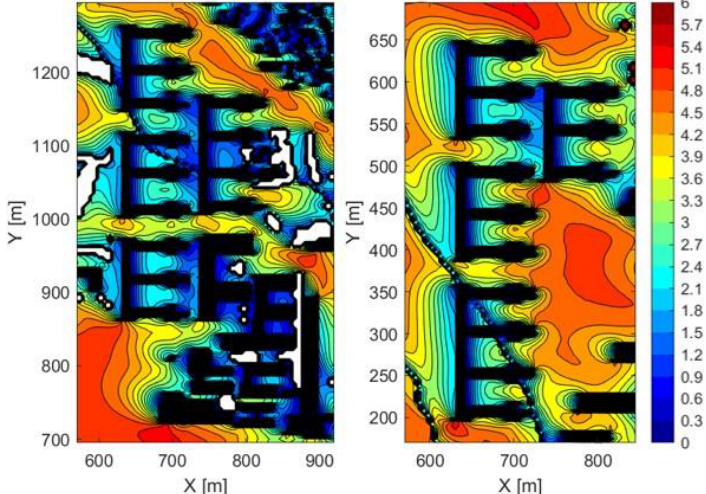
Figure 12. Wind velocity [m/s] at pedestrian level: on the left, in the current situation; on the right, in the planned situation.